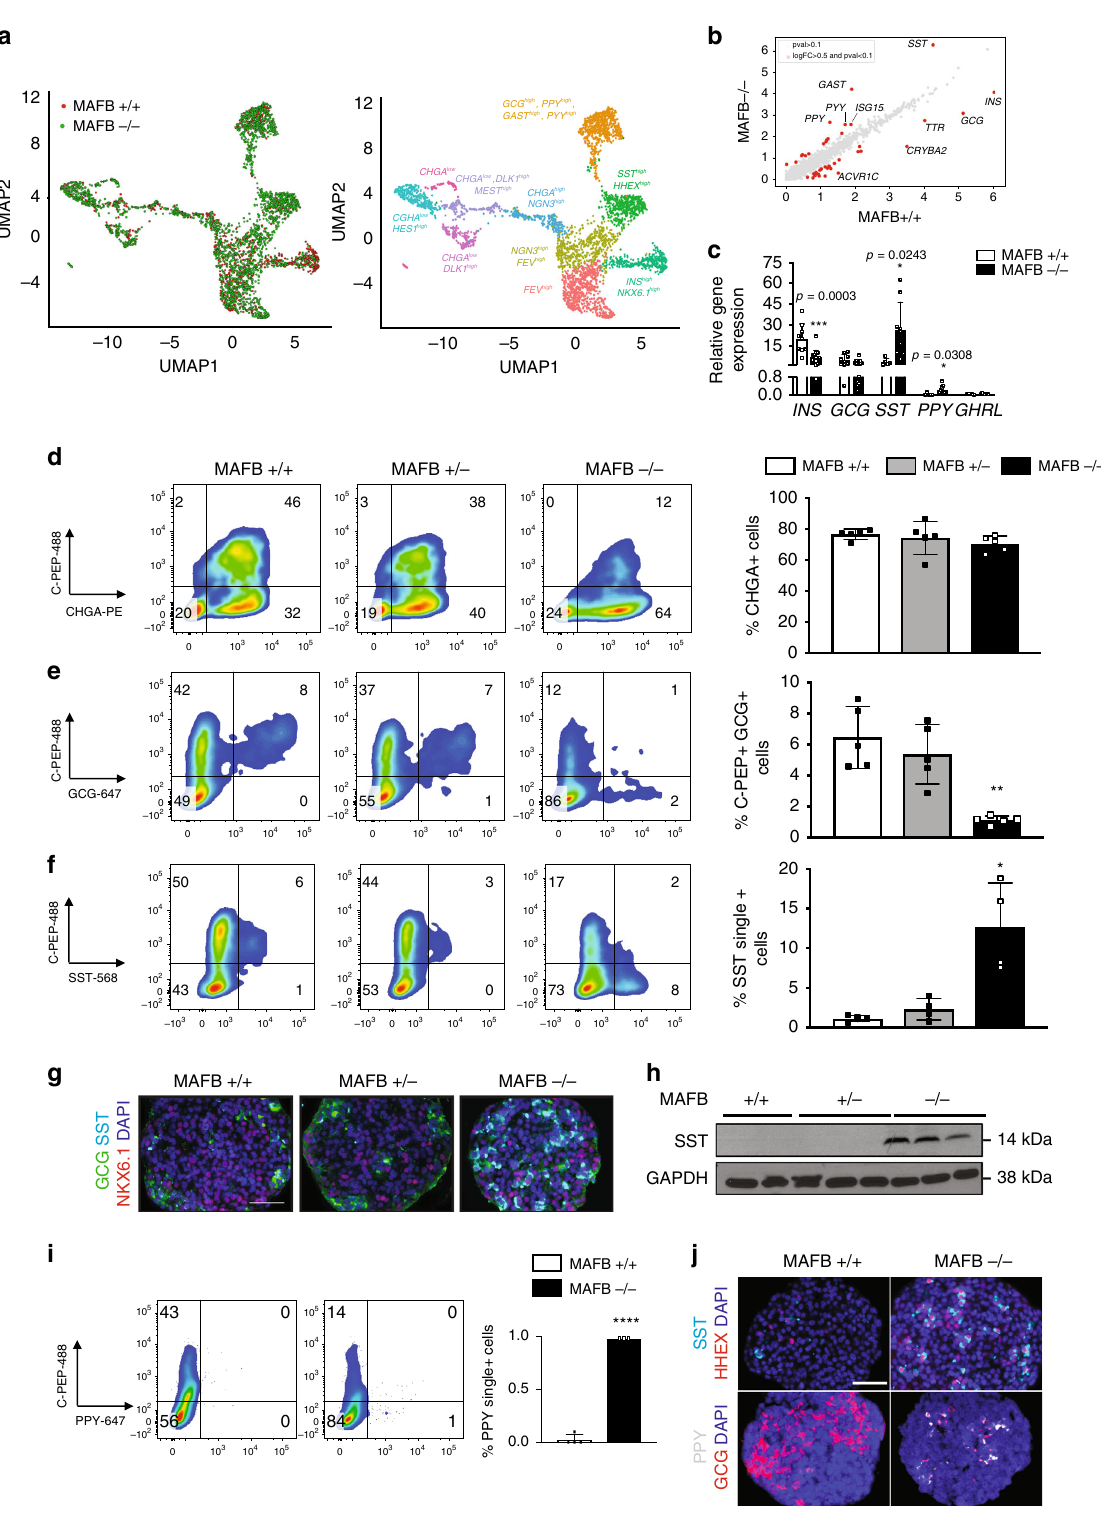
However, in line with the mRNA data, we found a signi fi cant increase in the levels of SST single positive cells in MAFB − / − cells (1 ± 0.5% vs. 2 ± 1% vs. 13 + 6%) as well as a dose-dependent reduction in the levels of GCG (6.5 ± 2% vs. 5 ± 1.8% vs. 1.2 ± 0.46%) (Fig. 4e, f). An overview of clonal cell lines is provided in Supplementary Fig. 9a – d. IF analysis con fi rmed SST was strongly upregulated in the MAFB − / − cells and were mostly single